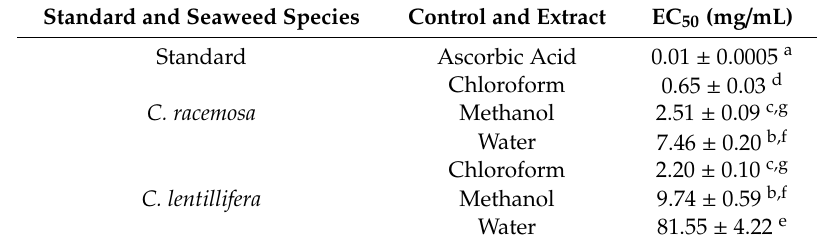
Table 3. The DPPH radical scavenging activity of C. racemosa and C. lentillifera crude